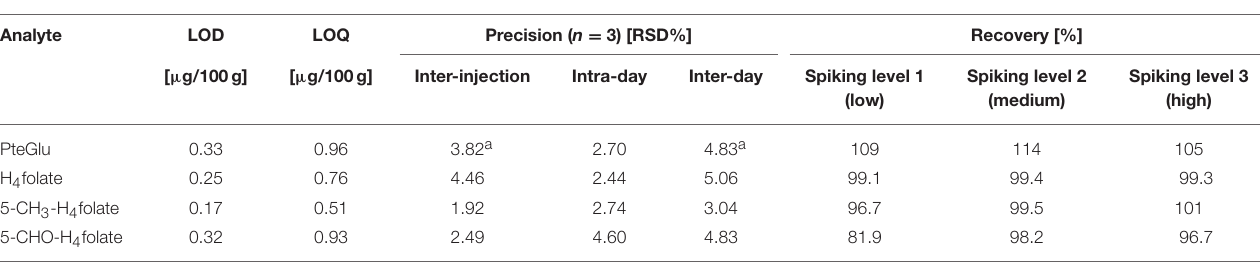
TABLE 2 | Validation data for the stable isotope dilution